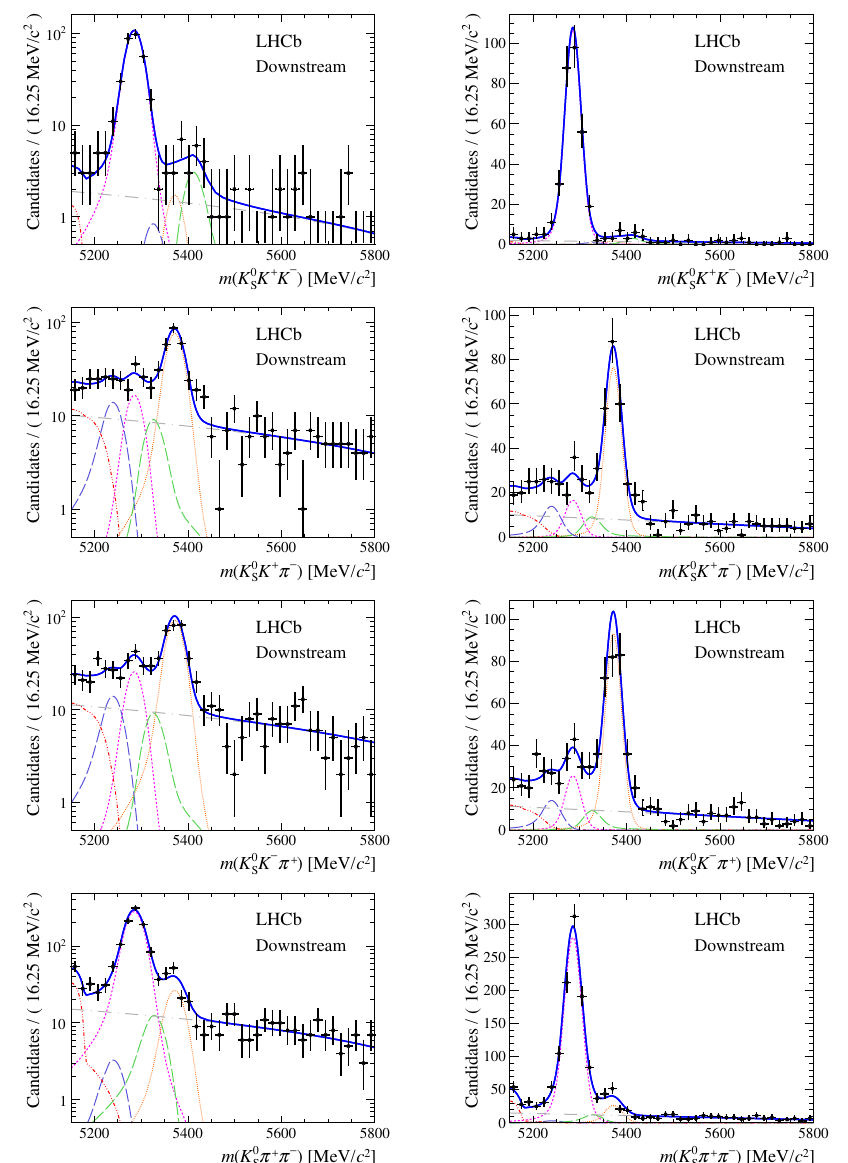
Figure 11 . Results of the simultaneous (cid:12)t to data (downstream, 2012b) with the BDT optimisation corresponding to the suppressed modes. The modes K 0 are shown from top to bottom. The left-hand side plots show the results with a logarithmic scale and the right-hand side with a linear scale. Legend is similar to that of plots shown in (cid:12)gure 1.